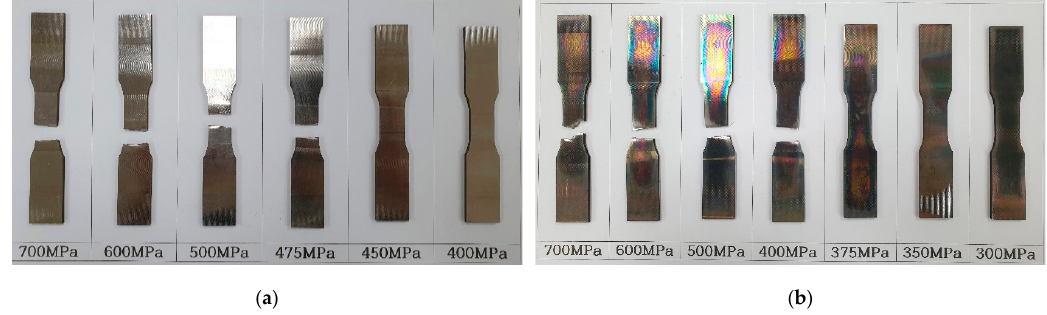
Figure 4. Test setup for fatigue tests.